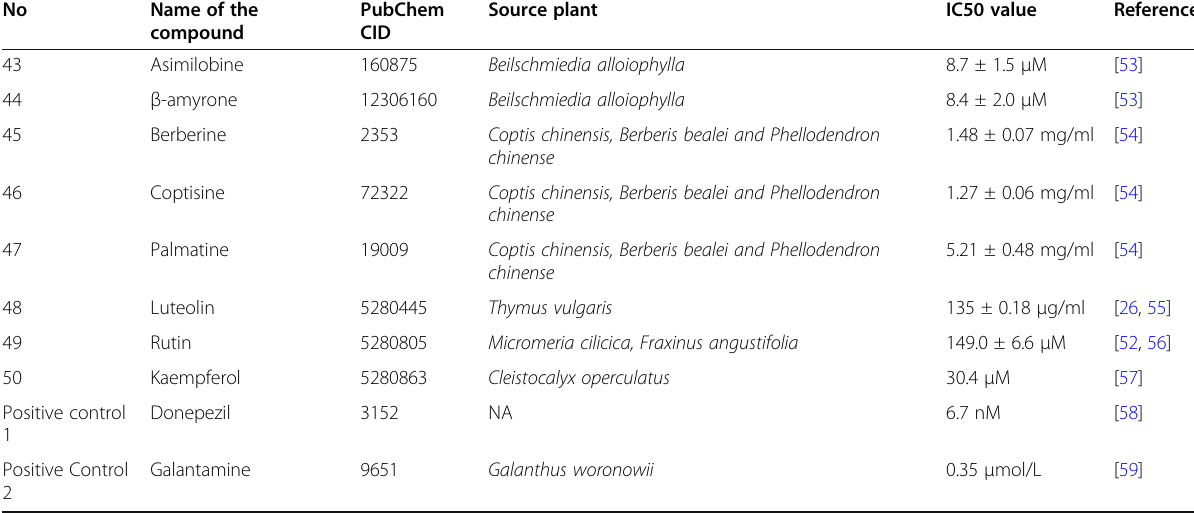
Table 2 List of the 50 anti-AChE ligands with their experimental IC50 values used in the experiment (Continued)